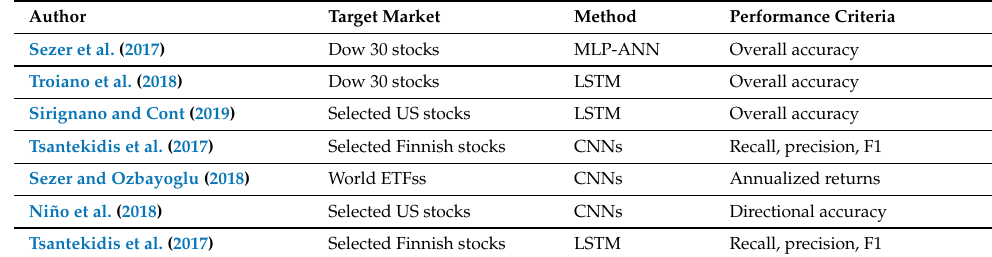
Table 6. Selection of papers for algorithmic